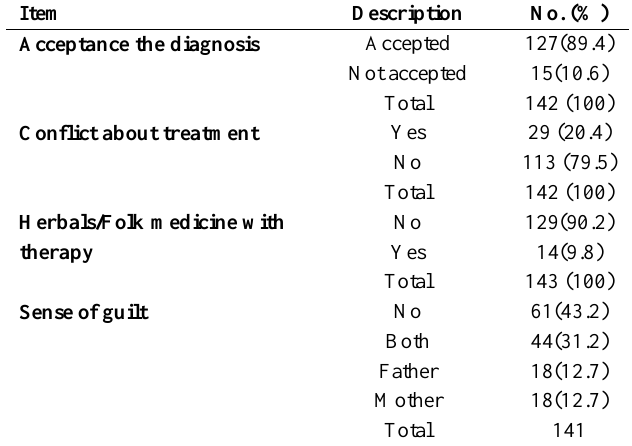
Table 3: Action of the parents